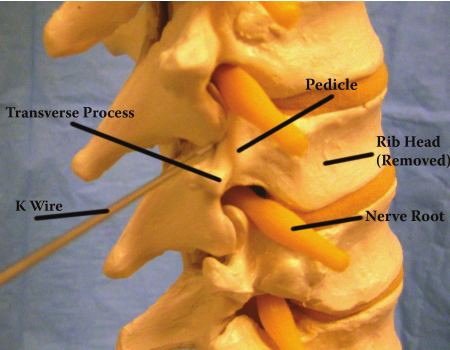
Figure 4: Saw bones image with a K wire showing the localization point for MIS lateral extracavitary corpectomy. Relevant anatomy highlighted.